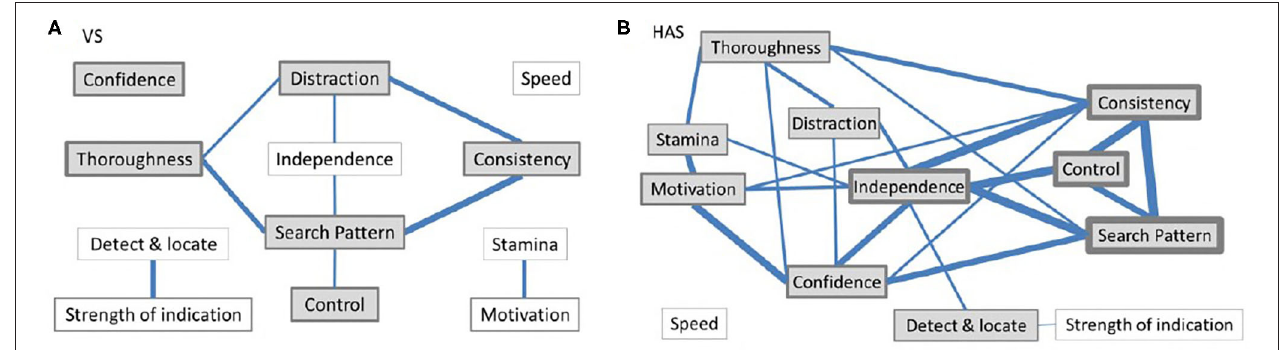
FIGURE 1 | Diagrammatic representation of discriminant validity (or lack of) between (A) VS and (B) HAS performance traits. Behaviors where at least three raters ( ∼ 20%) did not discriminate between them are connected, with thicker lines indicating a greater number of raters violating discriminant validity assumptions. Behaviors that correlated with Overall ability (using “all ratings”) are shaded, with the relative thickness of the border indicating the incidence of correlations (convergent validity). For values and coefficients see Tables 2 , 3 .